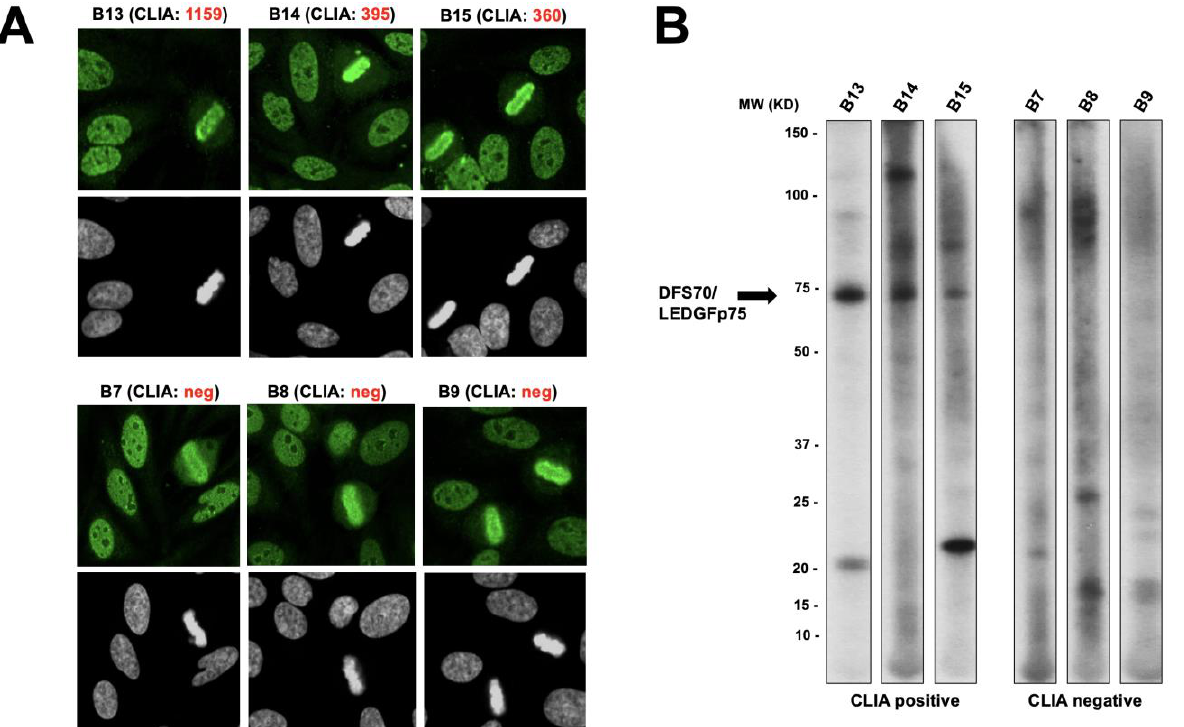
Figure 10. Analysis of a different cohort of CLIA anti-DFS70-positive and anti-DFS70-negative producing a speckled nuclear pattern. ( A ) The top panels show the classic DFS IFA patterns corresponding to anti-DFS70/LEDGFp75 antibodies produced by selected CLIA anti-DFS70-positive sera. The bottom panels show the pseudo-DFS IFA patterns produced by selected CLIA anti-DFS70-negative sera. Fluorescence images were obtained by confocal microscopy. Chromatin staining with DAPI is presented in black and white for better visualization. ( B ) Immunoblots of total proteins from PC3-DR prostate cancer cells were probed with selected CLIA anti-DFS70-positive and -negative sera. CLIA anti-DFS70-positive sera, but not CLIA anti-DFS70-negative sera, reacted with the 75 kD band corresponding to DFS70/LEDGFp75.